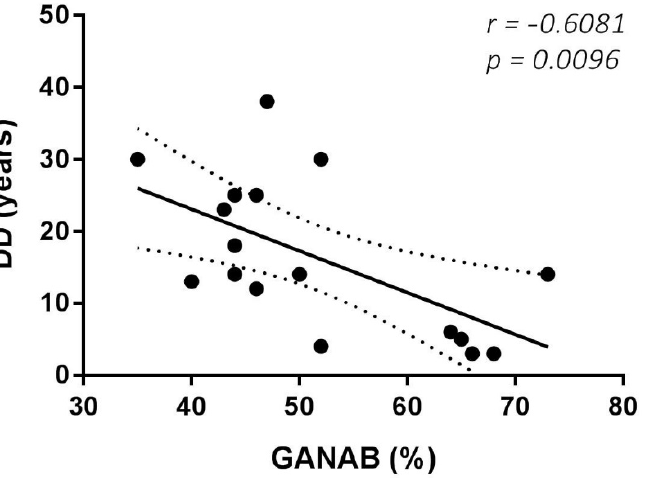
Figure 7. GANAB and DD correlation. Significant inverse correlation between GANAB (%) and DD (disease duration in years) in the untreated MS group.